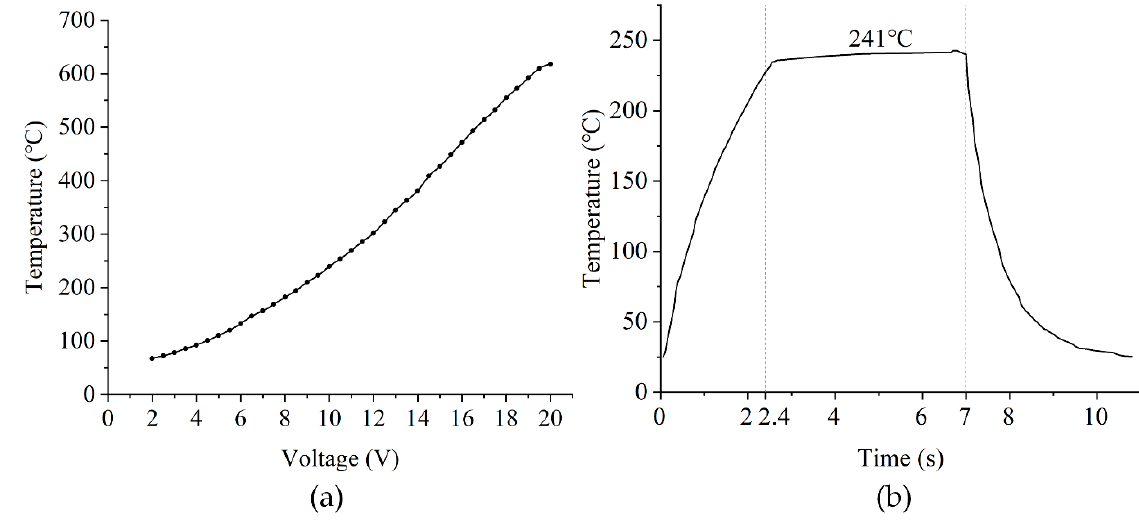
Figure 11. ( a ) Variation in micro-hotplate temperature with respect to input voltage. ( b ) Variation in maximum micro-hotplate temperature with respect to time at 10 V.